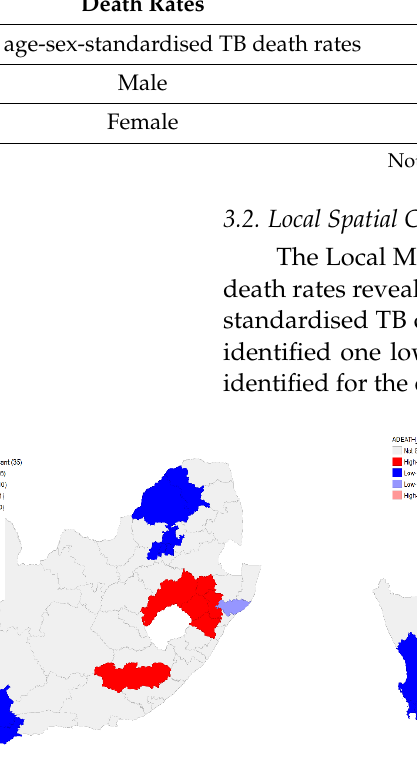
Sex Standardised TB Death Rates by District Municipality, 2010